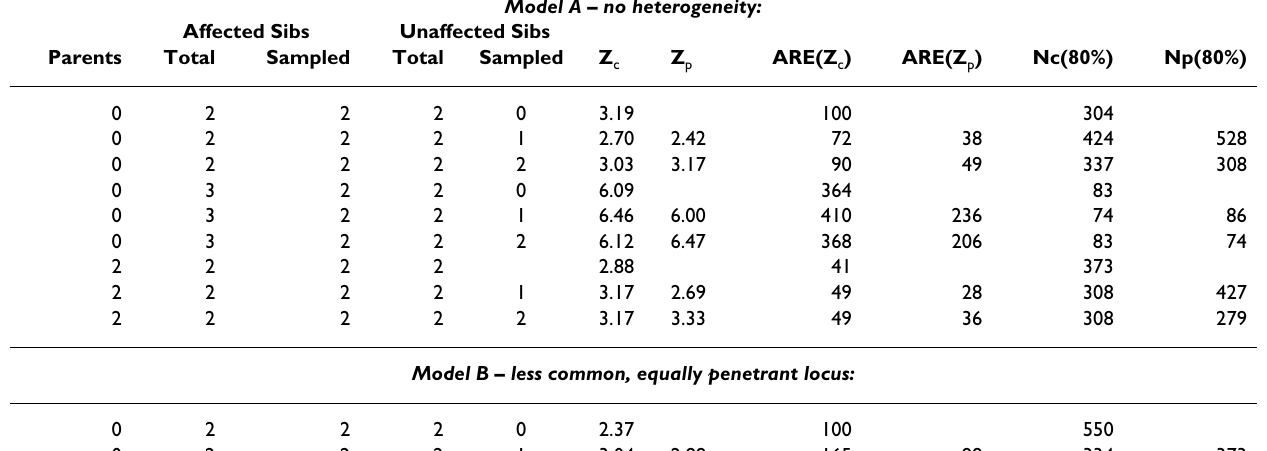
Model B – less common, equally penetrant